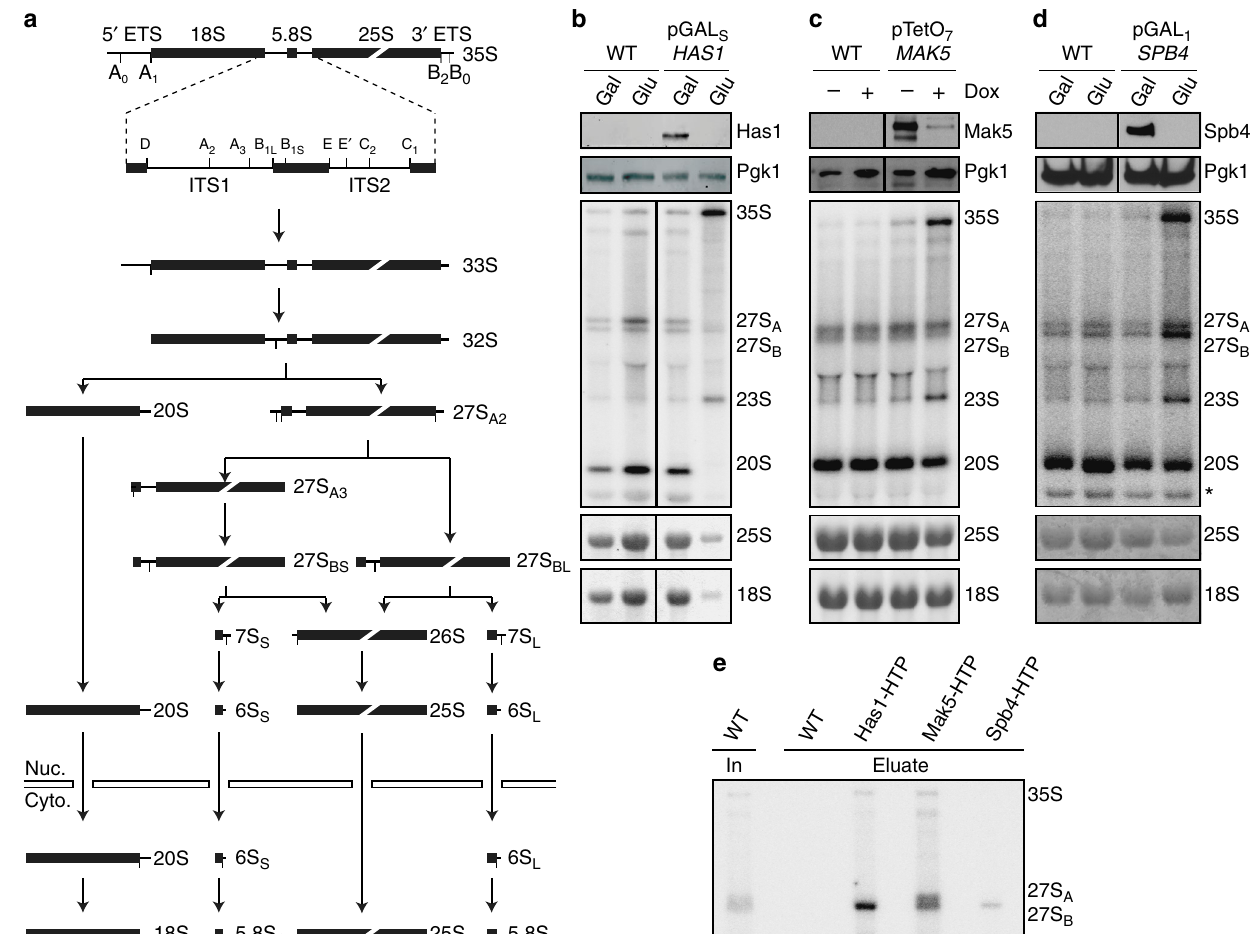
Fig. 1 Has1, Mak5 and Spb4 are required for different steps of pre-60S maturation. a Schematic overview of pre-rRNA processing in S. cerevisiae . Mature rRNA sequences are indicated by black rectangles, and internal transcribed spacers (ITS) and external transcribed spacers (ETS) are shown as black lines. Pre-rRNA cleavage sites are marked by grey vertical lines and are named on the 35S pre-rRNA transcript. b – d Wild-type (WT) yeast, the pGAL S -HA- HAS1 ( b ) and pGAL 1 -HA- SPB4 ( d ) strain were grown in YPD (Glu) and YPG (Gal) for 12 h, and WT yeast and the pTetO 7 -HA- MAK5 ( c ) strain were grown in the presence ( + ) or absence ( − ) of doxycycline for 10 h before harvesting. Proteins and RNAs were then extracted. Proteins were separated by SDS-PAGE and analysed by western blotting using an anti-HA antibody to detect the helicases and an anti-Pgk1 antibody as a loading control. RNAs were separated by denaturing agarose gel electrophoresis and pre-rRNAs were detected by northern blotting using probes hybridising in ITS1 and ITS2. Mature 25S and 18S rRNAs were visualised by methylene blue staining. Asterisk indicates cross-reactivity of the probes with the 18S rRNA. e Wild-type yeast (WT) and yeast cells expressing Has1-His 10 -TEV protease cleavage site-ProteinA (HTP), Mak5-HTP or Spb4-HTP were lysed, and complexes were retrieved on IgG sepharose and eluated by TEV protease cleavage. RNA was extracted from inputs (In; 1%) and eluates, and pre-rRNAs were detected as in ( b – d